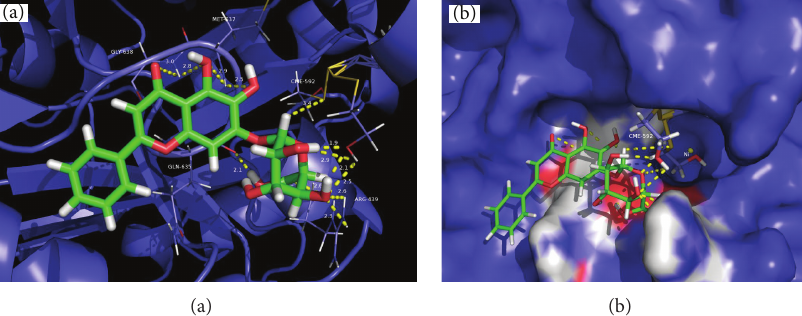
Figure 8: (a) Molecular docking simulations obtained at the lowest energy conformation, highlighting potential hydrogen contacts of BA (colored by atom: carbon is green; nitrogen is blue; oxygen is red; hydrogen is white; sulfur is yellow). For clarity, only interacting residues are labeled. Hydrogen bonding interactions are shown by dashes. These figures were created using PyMol. (b) Surface representation of the active-site flap of the jack-bean urease with BA shown at the entrance of the binding